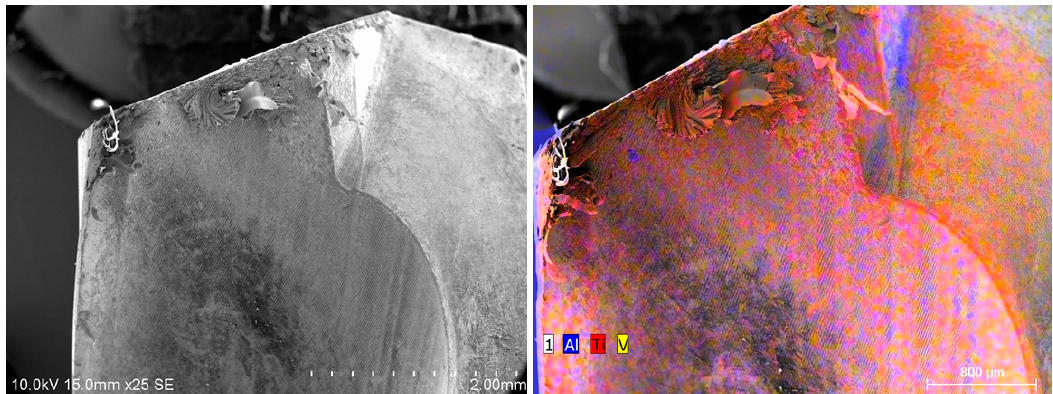
Figure 16. After drilling in the titanium alloy of the stack (26th hole), large adhesion zones of Ti on the tool appear again.